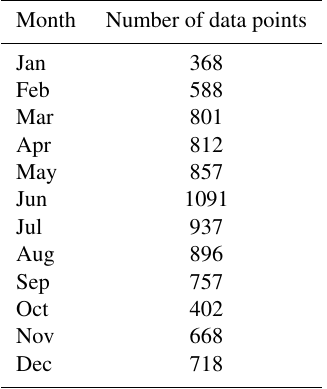
Table 1. The number of data points (1h averages) of the measured monoterpene concentrations for each month during